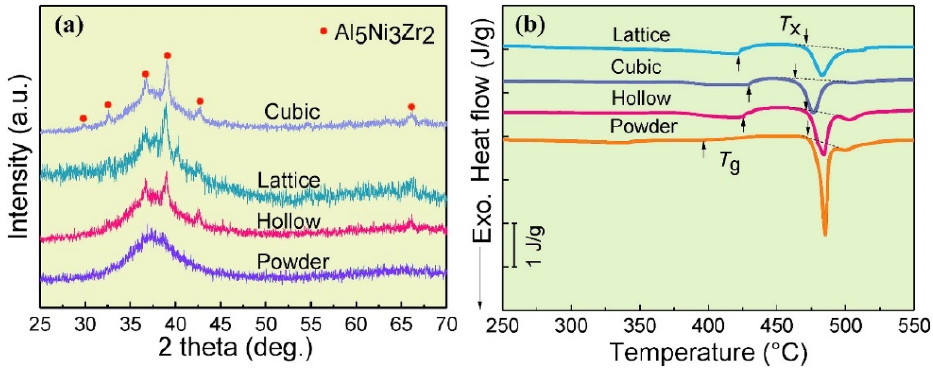
Figure 35. ( a ) XRD patterns of samples with different geometries and ( b ) DSC curves of the same samples. Reproduced from [36], with permission from Elsevier, 2021.